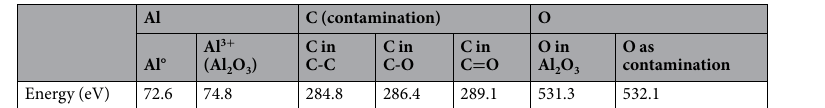
Table 4. XPS signals recorded on the wear track of the pure Al sample.